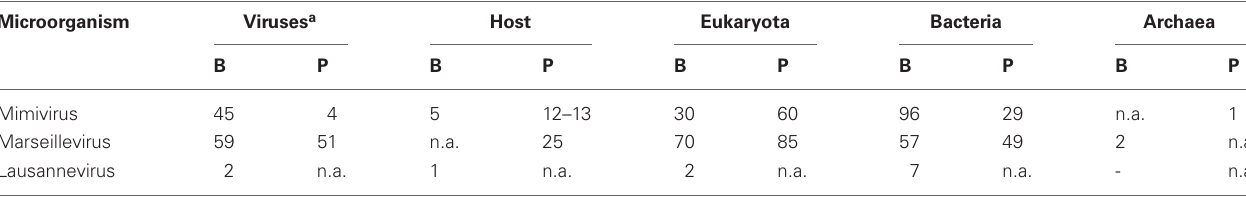
Table 4 | Events of lateral gene transfer with amoeba-resisting viruses.